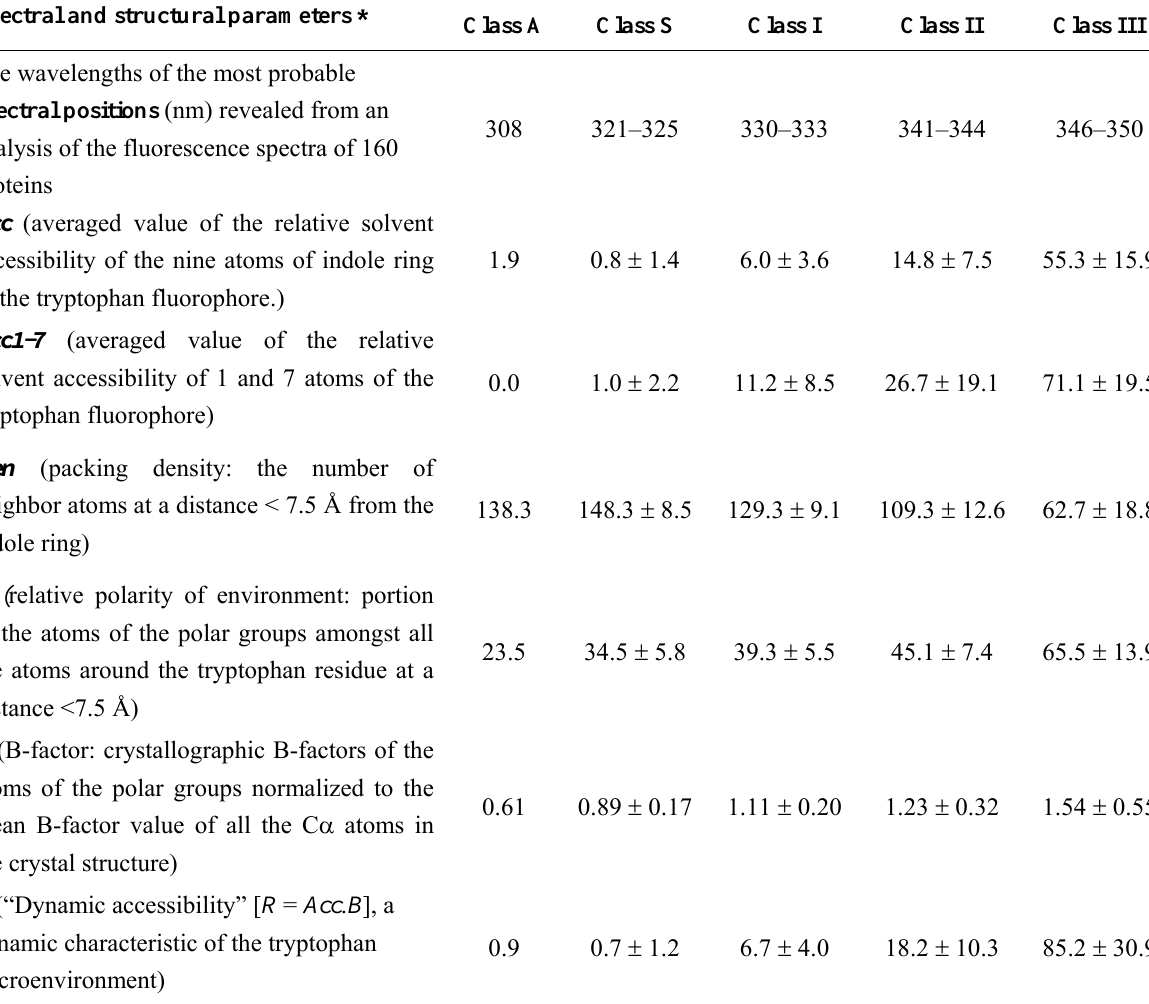
Table 1. The five spectral and structural